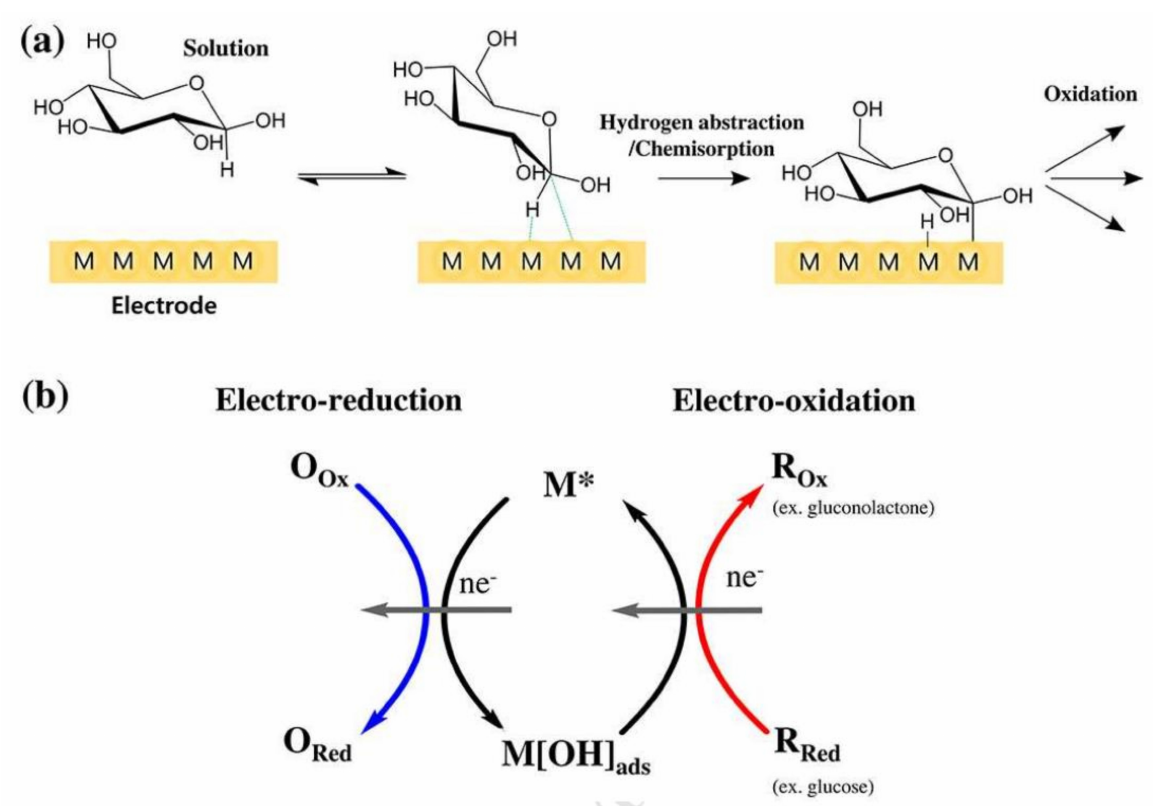
Figure 21. ( a ) The mechanism of oxidation of glucose. ( b ) The effect of reactive species in the fast conversion of glucose into glucono- δ -lactone. (Reproduced from [458] under common creative License